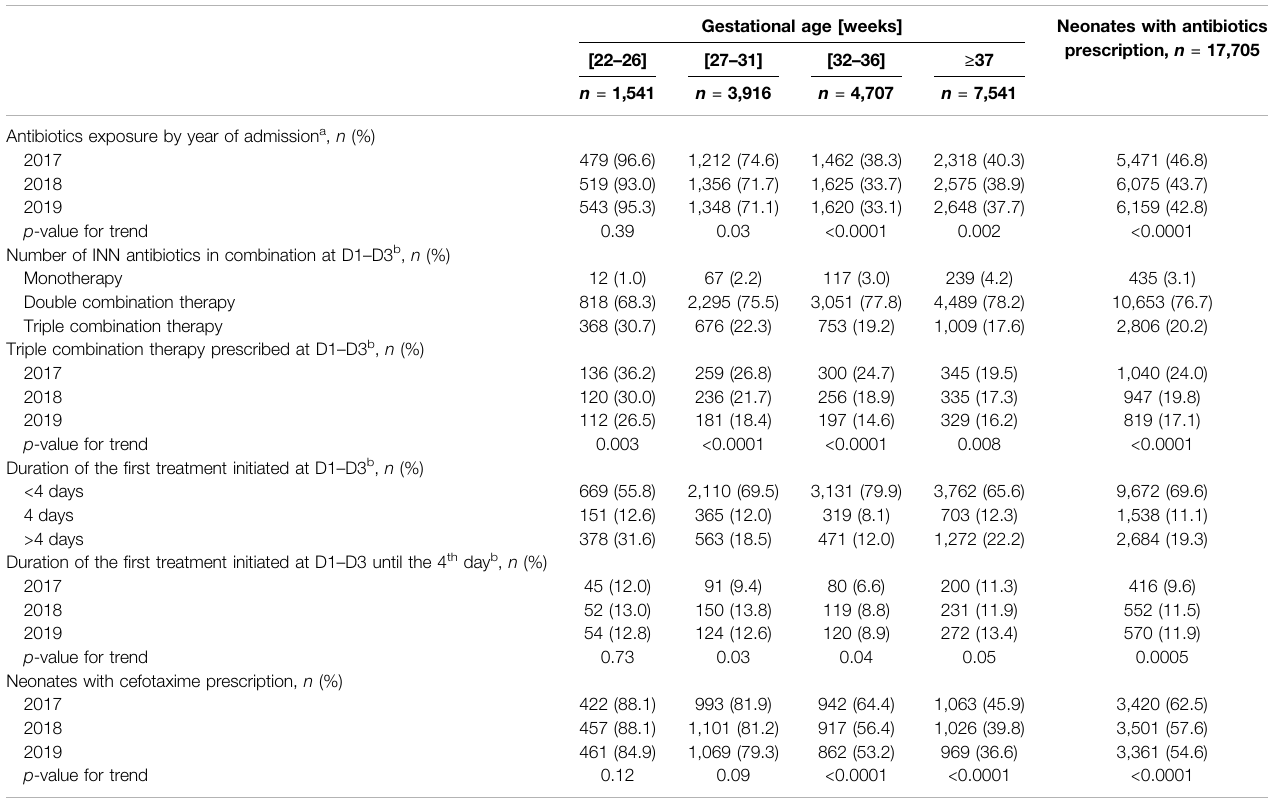
TABLE 3 | Antibiotic exposure, combination therapies, and duration of therapy by year of admission of